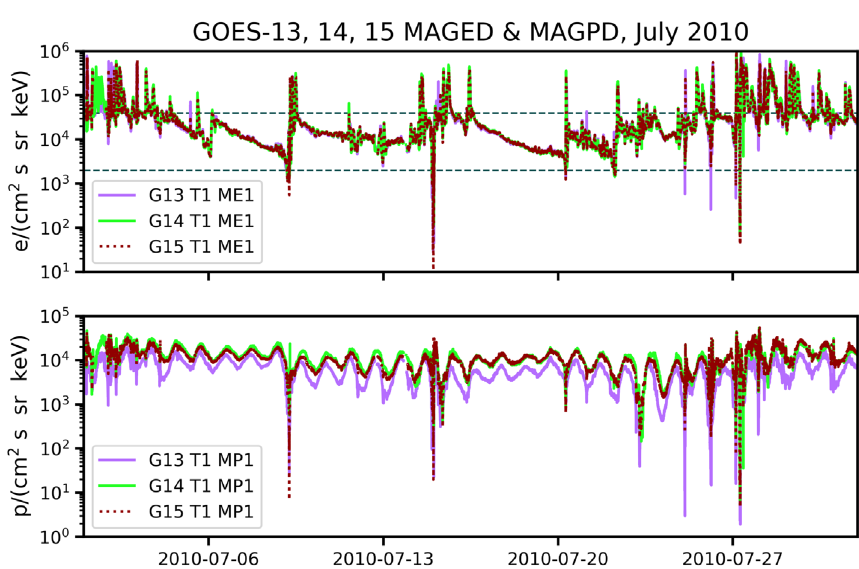
Fig. 3. (Upper panel) Electron fl uxes and (lower panel) proton fl uxes from GOES-13, 14 and 15 during July 2010, from Telescope 1 and the lowest energy channel (40 keV electrons, 95 keV protons). The upper dashed line indicates the approximate limit between plasma sheet electron fl uxes on open drift paths (above) and fl uxes on closed drift paths (below). The lower dashed line indicates the level below which the fl uxes correspond to dropouts.